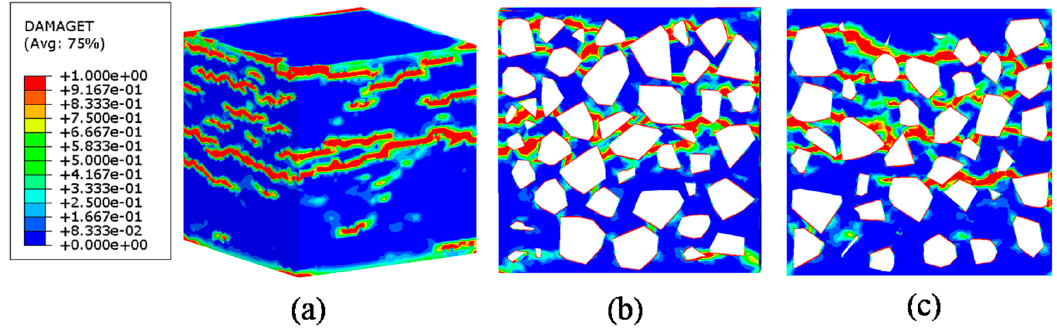
Figure 27. Failure patterns under tensile loading: View of 3D ( a ) and view of internal section ( b ) ( c ).